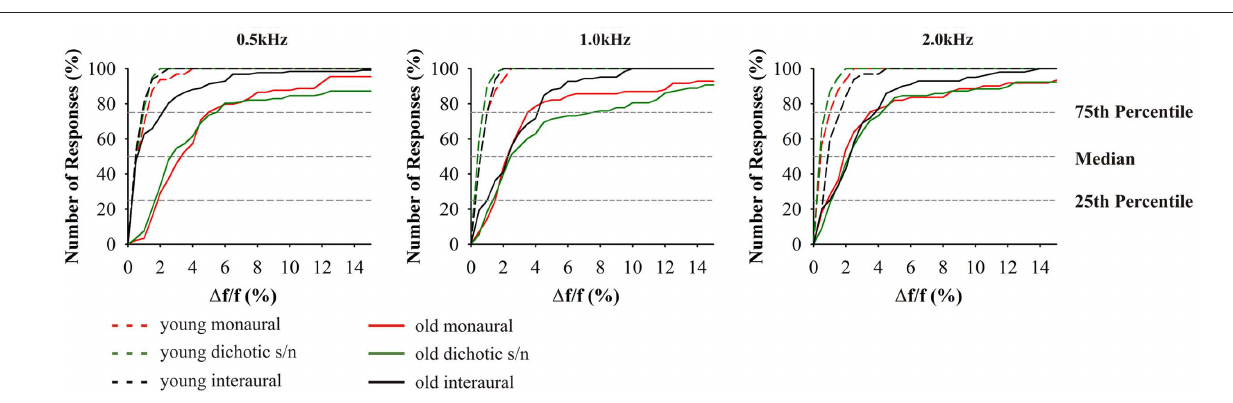
FIgure 5 | Cumulative distributions of JND of frequency discrimination; from left to right results for the test frequencies 0.5, 1.0, and 2.0 kHz. Since absolute values depend on the test frequency, JND are indicated as difference in percent from the respective test frequency. Red indicates: monaural stimulation of either